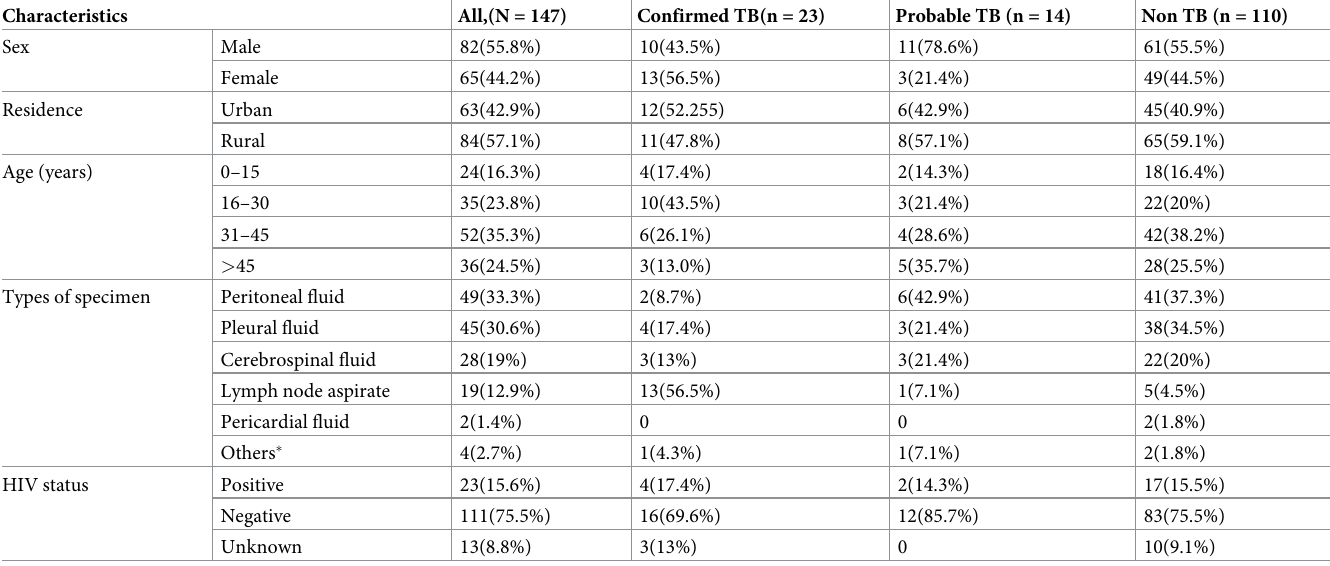
Table 1. Socio demographic and clinical characteristics of presumptive EPTB cases visited Jimma University Medical Center from April to October 2019(N = 147).